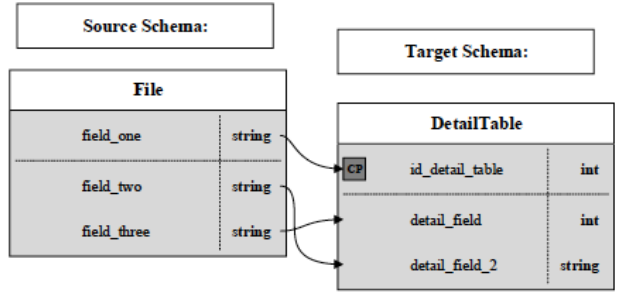
Fig. 3. Schema representation with a linear